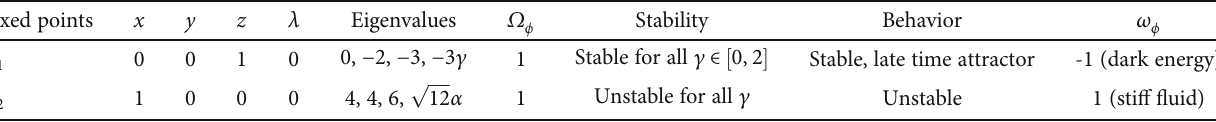
Table 3: Table for dynamical system with double exponential potential